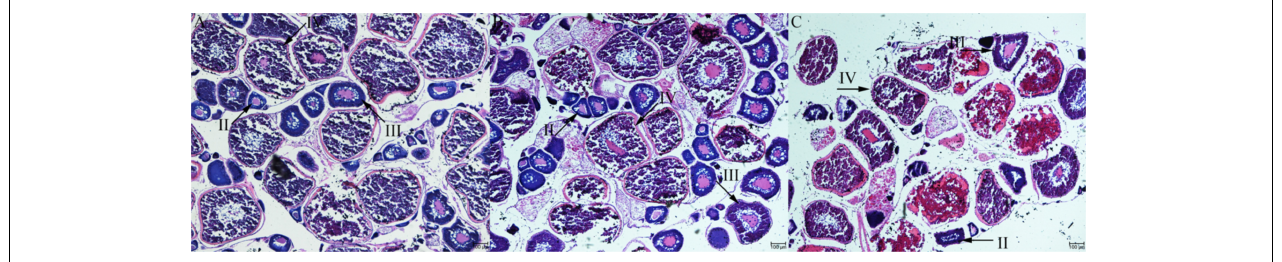
FIGURE 1 | Histological section of Japanese flounder ovaries at different stages of follicle development. stage II (A) , stage III (B) , and stage IV (C) . Scale bar = 100 µ m.